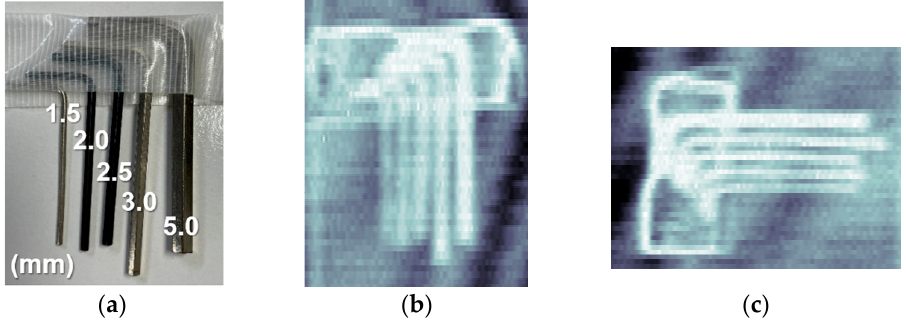
Figure 5. ( a ) Photo of the hexagon wrench set. ( b ) The imaging result of the hexagon wrench set in the vertical direction. ( c ) The imaging result of the hexagon wrench set in the horizontal direction.